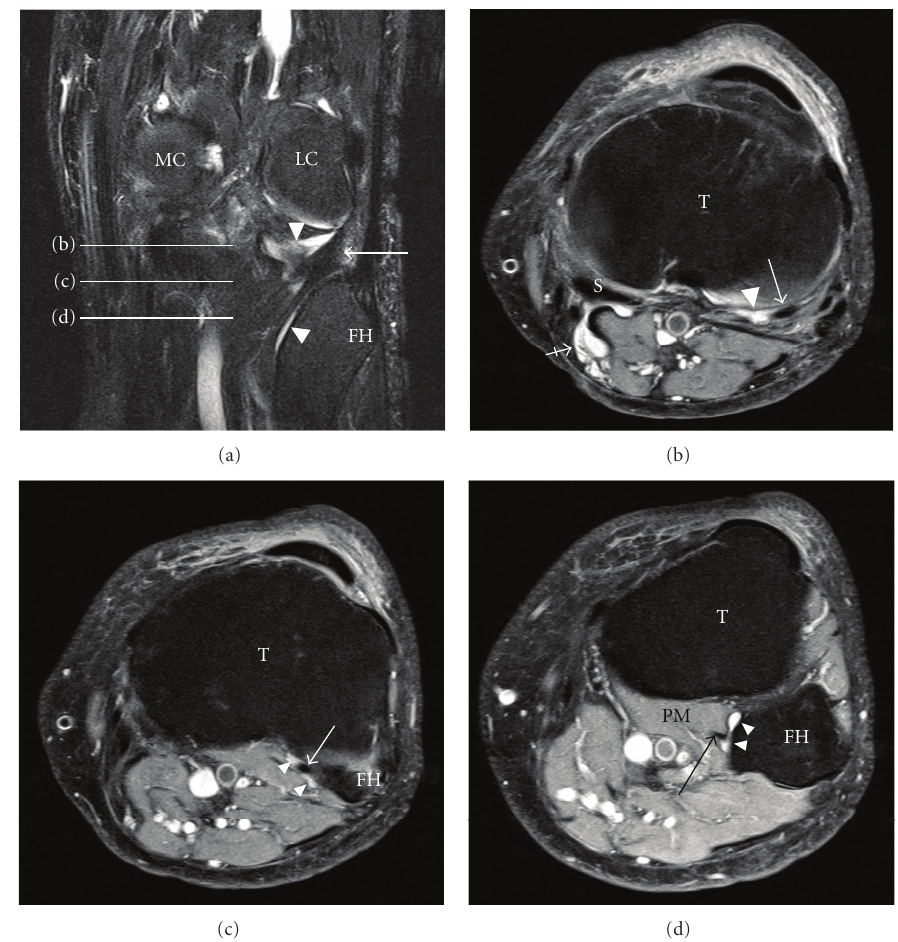
Figure 1: Synovial recess along the popliteus tendon presented at three distances from the popliteus hiatus. (a) Overview of the course of the popliteus tendon (arrow) and its intimately related synovial recess (white arrow heads) on a coronal MRI fat saturated T2-weighted image of the dorsal aspect of the left knee without e ff usion in a 64-year-old male floor layer. The white lines illustrate the level of the axial proton density fat-saturated images b, c, and d. (b) The popliteus tendon (arrow) is embedded in the synovial recess (white arrow head) close to the joint space of the knee. Popliteal cyst (crossed arrow) communicates with a subgastrocnemius bursa (black arrowhead). (c, d) Note the characteristic appearance of the not distended synovial recess (arrow head) of a branch of the popliteus tendon (arrow) at the level of the fibular head (FH). The recess should not be mistaken for a ganglion cyst originating from the proximal tibiofibular joint. MC and LC, medial and lateral femoral condyle; T, tibia; S, semimembranosus tendon; PM, popliteus